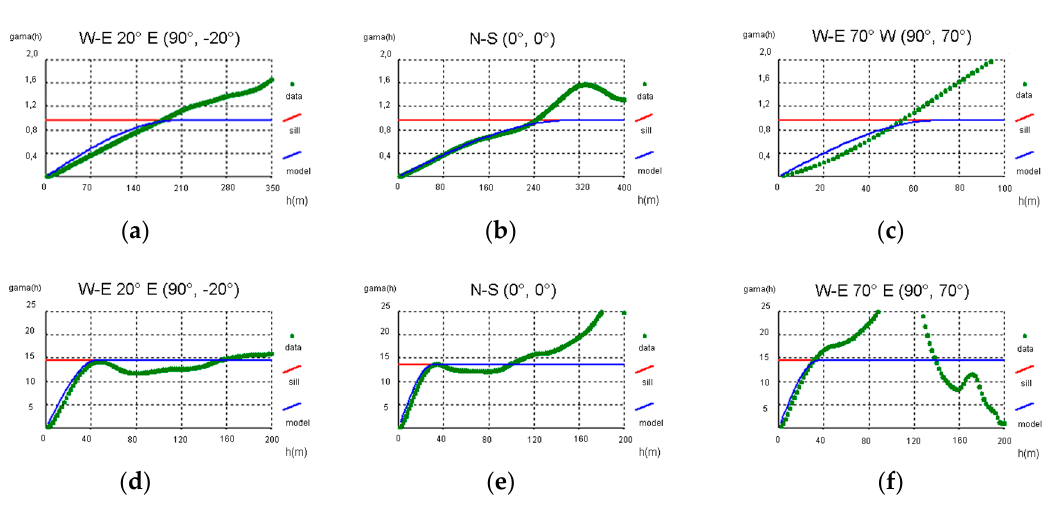
Figure 8. Experimental variograms of P ( x ) and Y Cu ( x ) variables for the three OX, OY, and OZ directions: OX similar to W-E 20° E (90°; − 20°), OY similar to N-S (0°; 0°) and OZ similar to W-E 70° W (90°; 70°). ( a ) SPH1 (C 1 = 0.106; a 1 = 300 m); ( b ) SPH 1 (C 1 = 0.106; a 1 = 200 m); ( c ) SPH 1 (C 1 = 0.106; a 1 = 60 m); ( d ) SPH 1 (C 1 = 14,986; a 1 = 55 m); ( e ) SPH 1 (C 1 = 14,986; a 1 = 30 m); ( f ) SPH 1 (C 1 = 14,986; a 1 = 35 m).